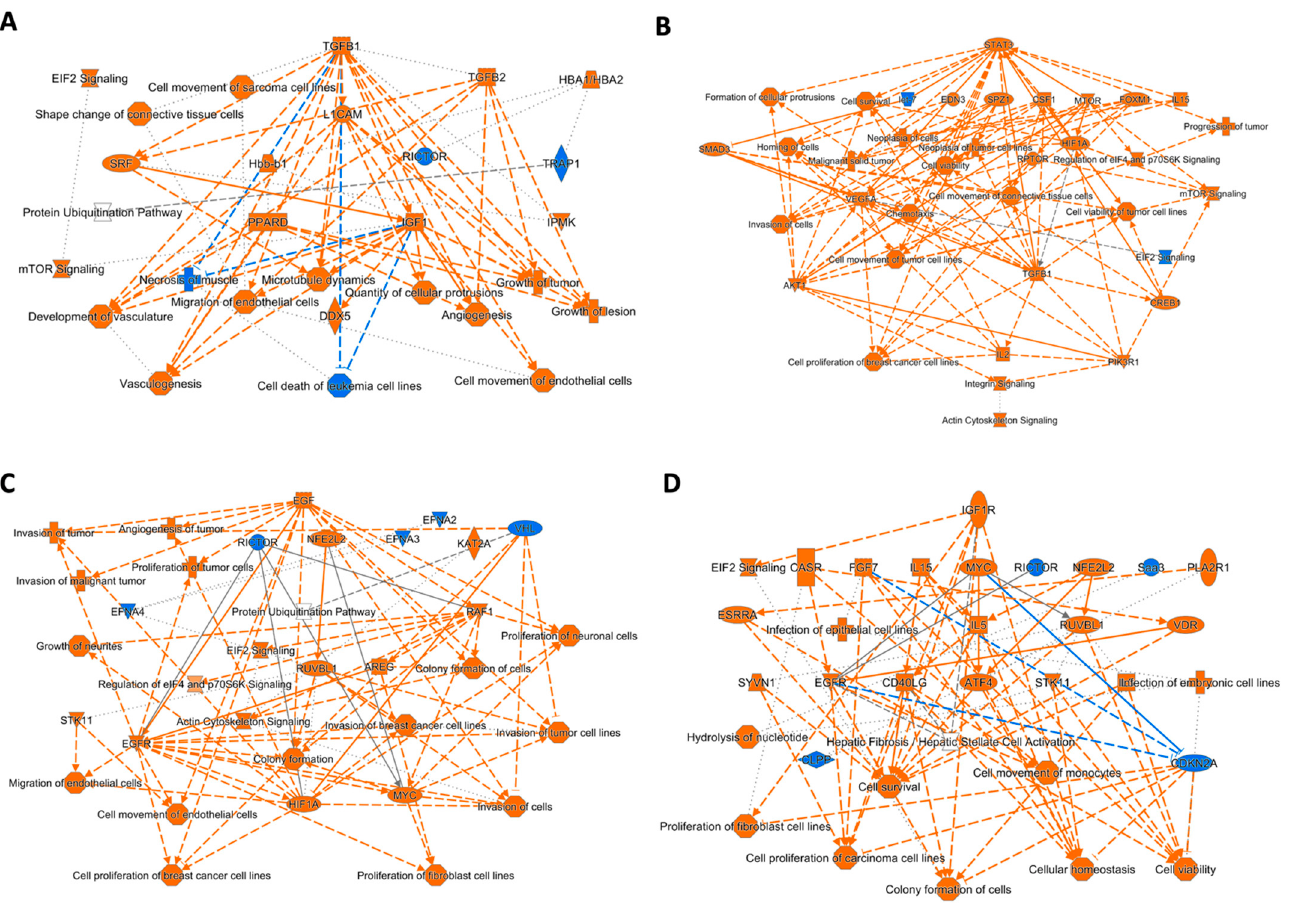
Figure 3. Graphical summaries of IPA pathway analysis. Nodes significantly upregulated (orange) and downregulated (blue) in HDF cell lysates after 24 h ( A ) and 48 h ( B ) of treatment with CM. Nodes significantly upregulated (orange) and downregulated (blue) in HDF supernatants after 24 h ( C ) and 48 h ( D ) of treatment with CM.